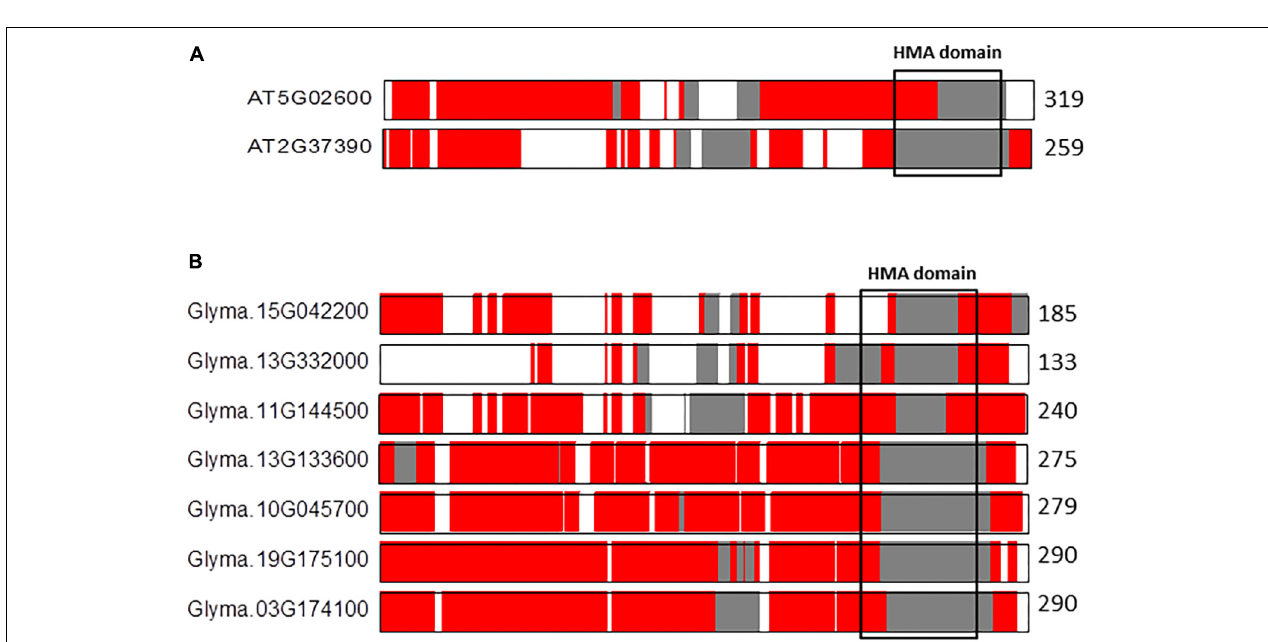
FIGURE 4 | Alignments of the co-linear GATA10 (A) and NAC92 (B) paralogs in A. thaliana . The protein length is given to the right of each sequence. The color coded bars in each sequence depict predicted disorder. Disordered residues are shown in red, ordered residues are shown in gray, and alignment gaps are shown in white. Typical DNA-binding domains are shown as black boxes.